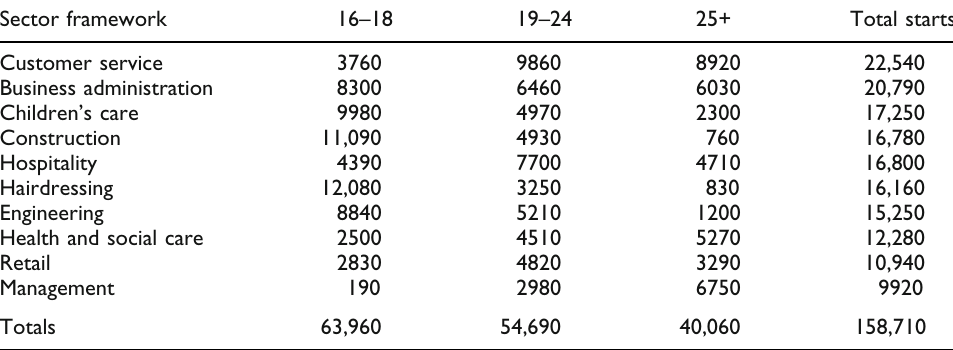
Table 1. Apprentices by top ten framework sectors and age,